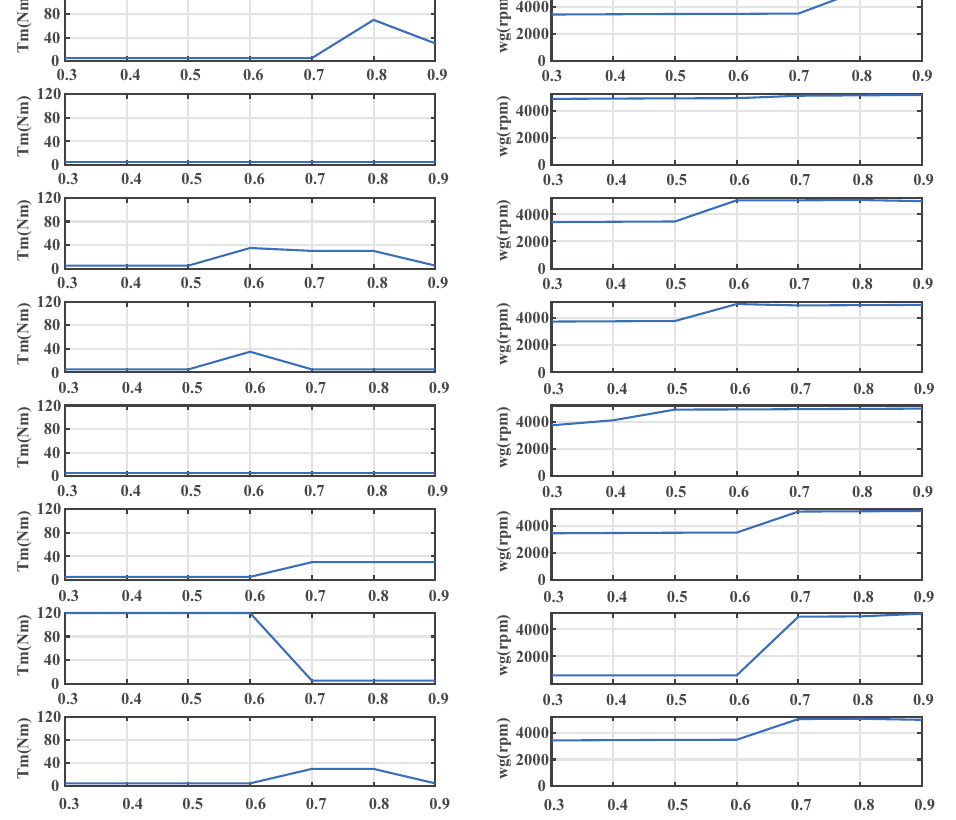
Figure 9. Static maps of the control policy with the consideration of battery life in eight